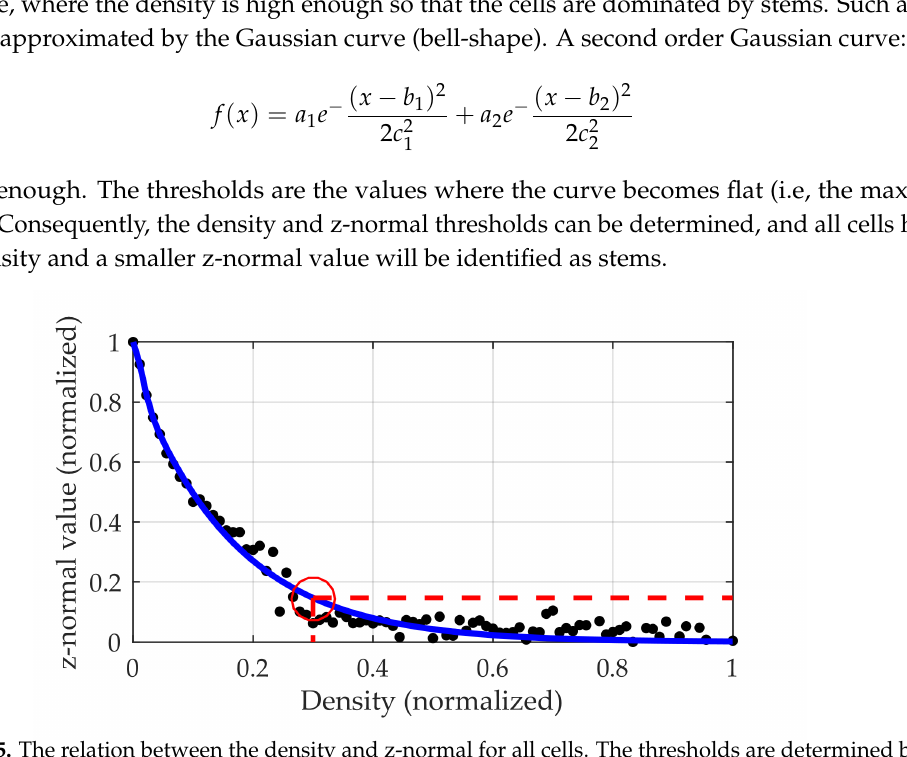
Figure 5. The relation between the density and z-normal for all cells. The thresholds are determined by finding the maximum curvature, at which the curve becomes flat. The cells framed by the red dotted line rectangle are identified as